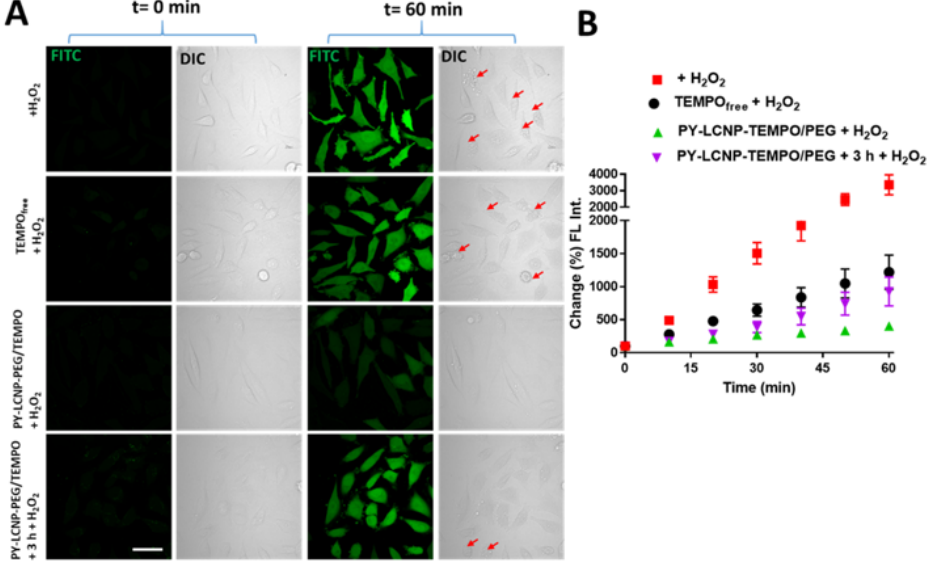
Figure 3. Quantification of extracellular ROS-scavenging efficiency of PY-LCNP-PEG/TEMPO and TEMPO free . ( A ) DIC and confocal fluorescence images of live HeLa cells at 0 and 60 min of incubation with 500 µ M of H 2 O 2 . The fluorescence images show green emission of the ROS probe H2DCFDA in untreated cells, cells treated with TEMPO free , and cells treated with PY-LCNP- PEG/TEMPO immediately prior to or 3 h before exposure to H 2 O 2 . The red arrows in the DIC images indicate areas of membrane blebbing (scale bar, 50 µ m). ( B ) Time-resolved quantification of the emission intensity of H2DCFDA showing changes (%) in the level of H 2 O 2 -induced ROS in the cells during 60 min incubation. The data for each sample were derived from the green emission intensity of the individual cells (50–80 cells) from three independent experiments ( n = 3 ± SEM), and are normalized to the emission intensity at the beginning of the